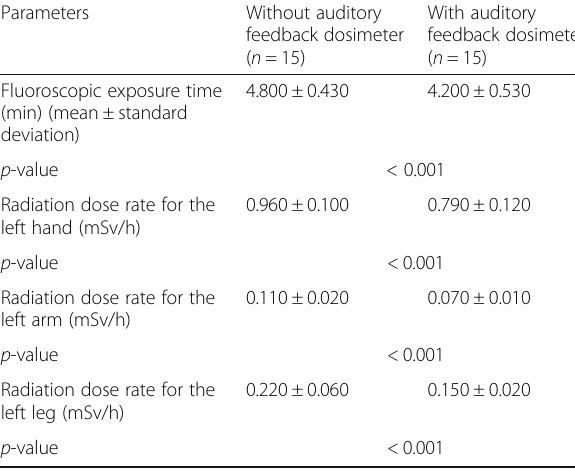
Table 2 Fluoroscopic exposure time and radiation dose rates with and without auditory feedback